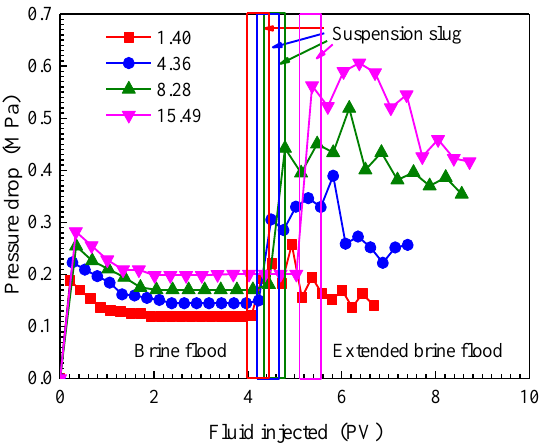
Figure 8. Curves of pressure drop as a function of the pore volume of fluid injected under di ff erent permeability ratios.